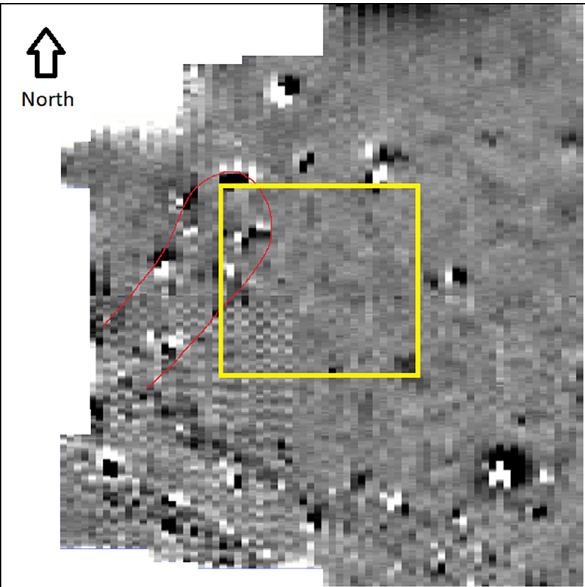
Figure 9: Round Top B Area Geophysical Survey from 2007, University of Akron. The culvert area is drawn in red, and the approximate location of the metal detector survey is outlined in yellow. Note the parallel lines to the southwest, which is the location of an extant gravel access road. Image courtesy Tim Matney. Nanotesla per meter values could not be located from original survey.